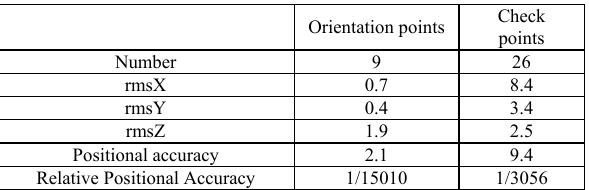
Table2. Precision of the north wall of fluted circumvallation (unit: mm, sigma naught value: 1.970 μ m)